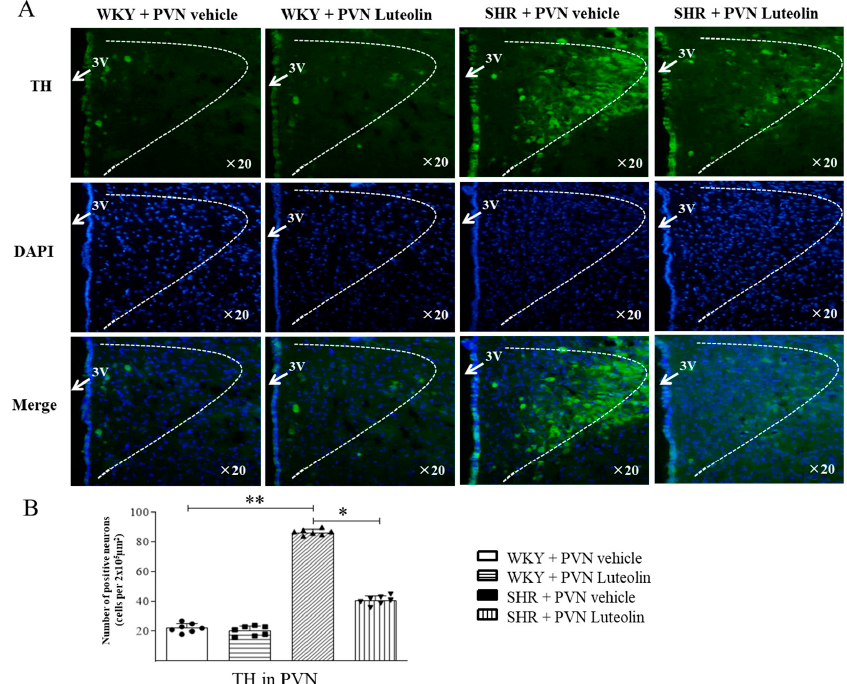
Figure 6. Effects of PVN luteolin on TH in PVN. ( A ) A representative immunomicrographs reporting TH positive cell (green fluorescence). ( B ) Quantification of the number of TH positive cells in PVN of SHRs and WKY rats, with or without luteolin treatment. Values are the mean ± SEM from 7 rats/group. * p < 0.05, ** p < 0.01. 3V, third ventricle . 3.7. Luteolin Decreased the Production of GAD67 in the PVN of SHRs Conversely to that of TH, the production of GAD67 (evidenced by the lower number of positive cells, Figure 7A,B) was decreased in the PVN of SHRs, and raised by luteolin infusion only in SHRs.